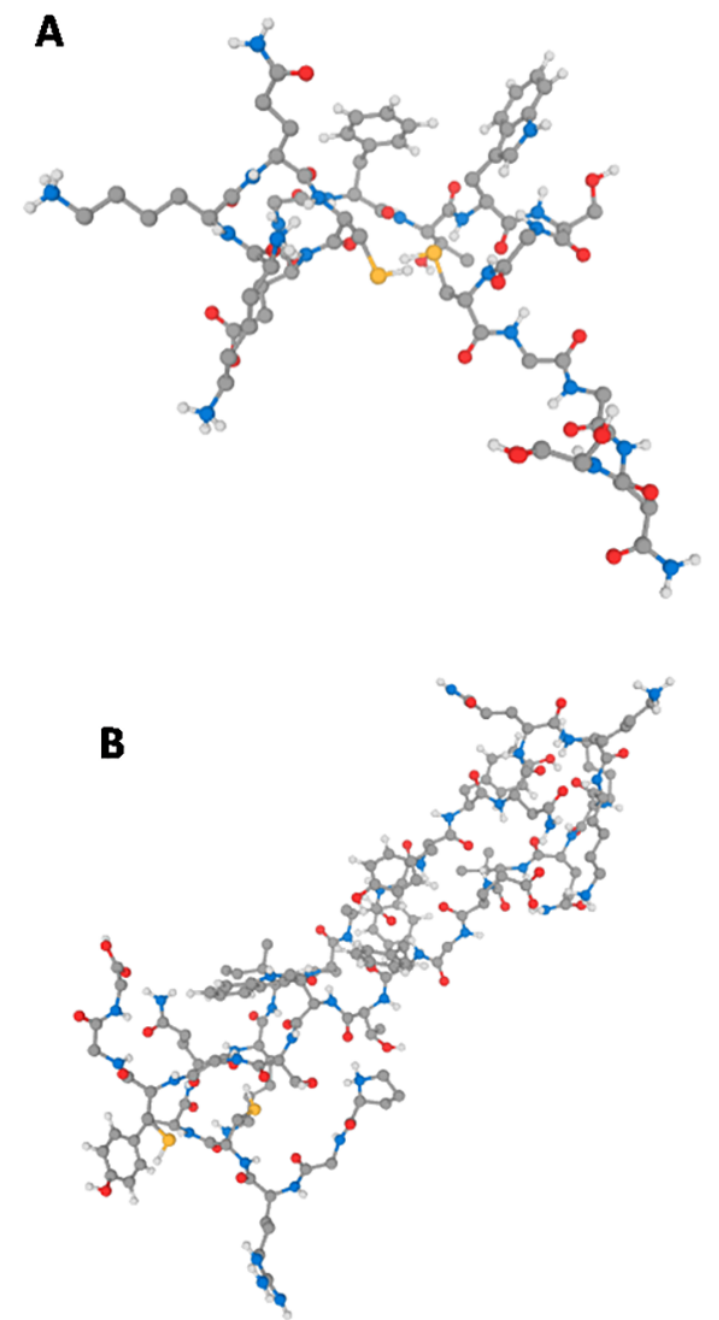
Figure 6. (A) Predicted 3D model of PEP1 (KKQCEGFTWSGCGGNS) in the PEP-FOLD server, carbon in gray, hydrogen in white, nitrogen in blue, oxygen in red and sulfur in yellow. (B) Predicted 3D model of PEP1 (PGRCYQKIPAFYYNQKKKQVEGFTWSGCGG) in the PEP-FOLD server, carbon in gray, hydrogen in white, nitrogen in blue, oxygen in red and sulfur in